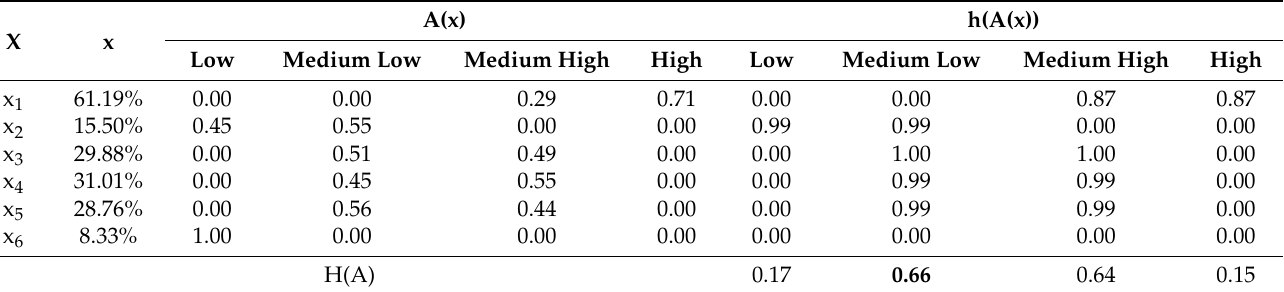
Table 2. Calculus of the fuzziness of the 4 fuzzy sets in Figure